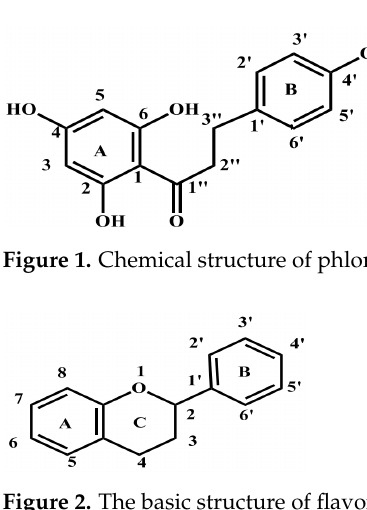
Figure 2. The basic structure of